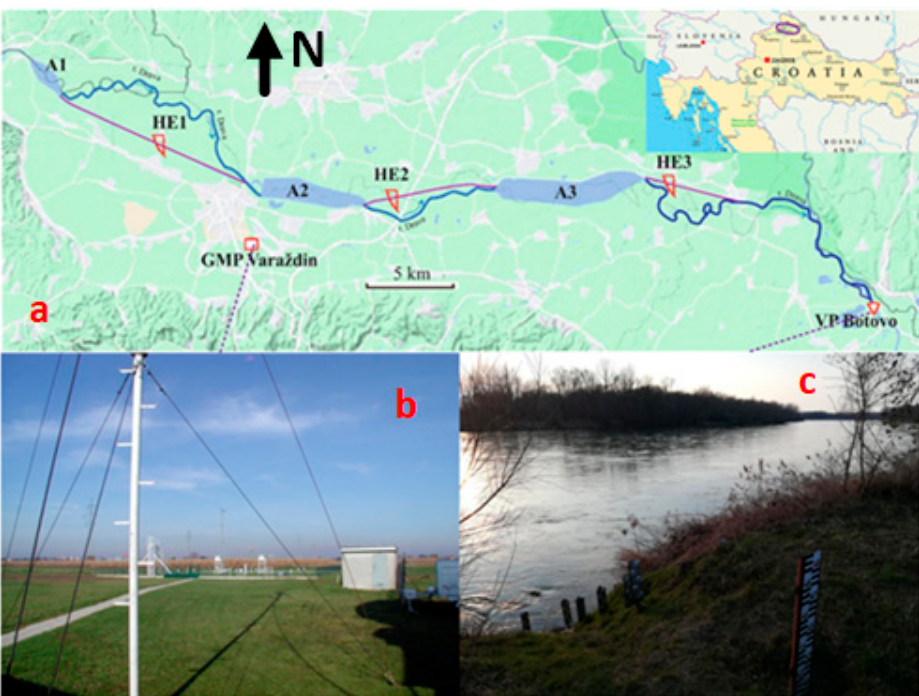
Figure 1. ( a ) Map of the analyzed area (purple ellipse) with marked positions for the reservoirs: A1, A2, A3, hydroelectric power plant: HE1, HE2, HE3, ( b ) central meteorological station (GMP) Varaždin, ( c ) the water measuring station (VP) Botovo on the Drava River, with their pictures